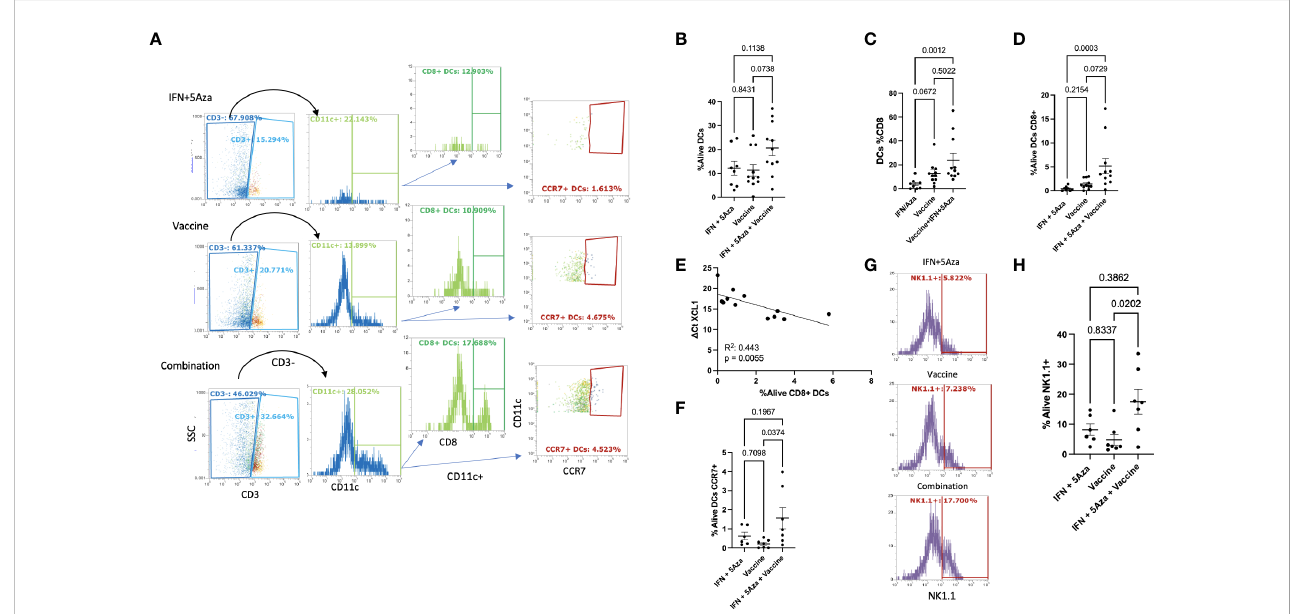
FIGURE 3 Dendritic Cell and Natural Killer Cell Tumor In fi ltration. (A) Gating of DCs. Single, live, leukocytes (Figure 1B) were selected for CD3 negativity and CD11c positivity to determine the DC population. DC ’ s were analyzed for CD8 and CCR7 expression. Plots shown are representative samples from their groups. (B) %Alive analysis of total DCs. (C) Analysis of the percentage of DC ’ s that are CD8+ per group. (D) %Alive analysis of CD8+ DCs. (E) Correlation of XCL1 expression versus %Alive analysis of DC ’ s expressing CD8. (F) %Alive DC ’ s expressing CCR7. (G) Representative gating of NK1.1 positivity. (H) %Alive of NK1.1 positive cells. All data represent 2-3 independent experiments with sample sizes ranging from 3-5 per group per experiment, except panel E, which represents one experiment. Group comparisons were tested by One-Way Anova with multiple comparisons test (Tukey ’ s if approximately Gaussian (F) or Dunn ’ s if not (B – D, H) . Correlations analyzed by Spearman (E) correlation coef fi cient